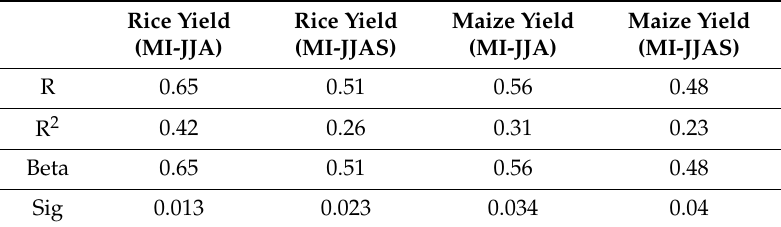
Table 4. Linear regression analysis for maize and rice yield.